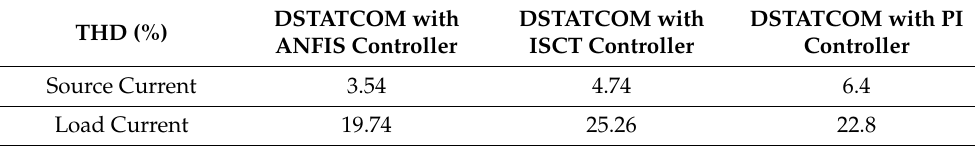
Figure 14. QS: Source reactive power, QL: load reactive power, and QC: Compensator reactive power. The THD value of the unbalanced loading condition using ANFIS controller is com- pared with the (recent 2020 published) ZSI supported DSTATCOM, whose IGBTs switching pulses are developed by using the ISCT control technique as shown in Table 2. Good improvement in the THD is observed using the proposed PV-based DSTATCOM. Table 2. Comparison of THD with the latest controller.